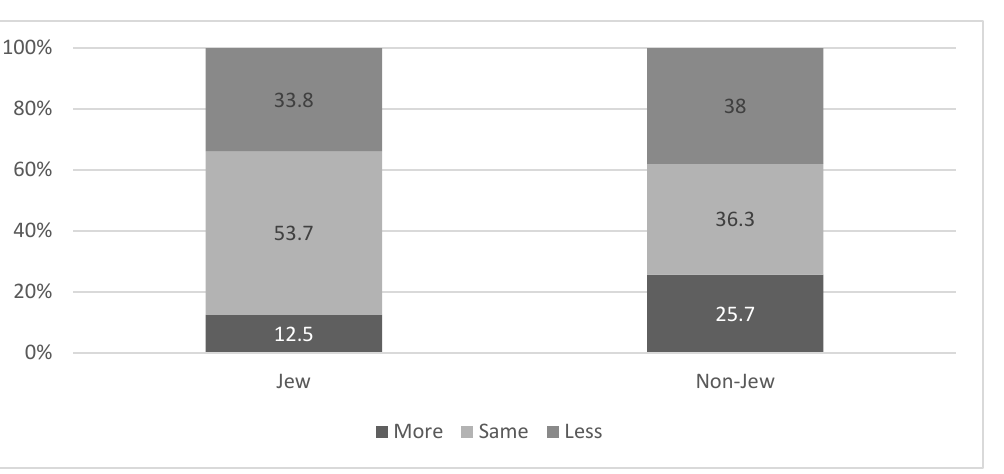
Figure 3. Fear of being infected with the Coronavirus following the beginning of the vaccination campaign, according to ethnic affiliation. χ 2 = 27.45 p < 0.001.